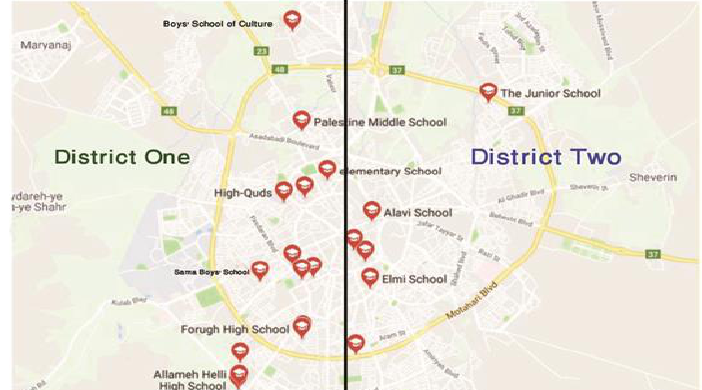
Fig. 1. School location map of Hamadan